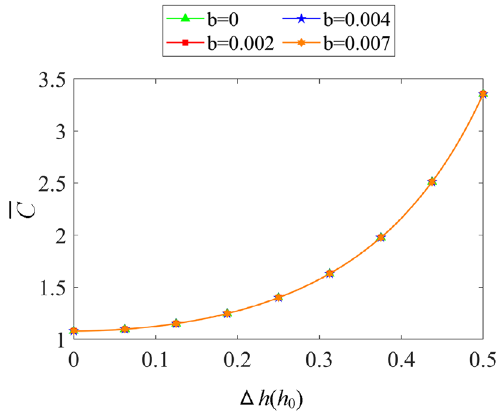
Figure 14. Influence of boundary slip on oil film damping coefficient ( ω 2 = 0 rpm).